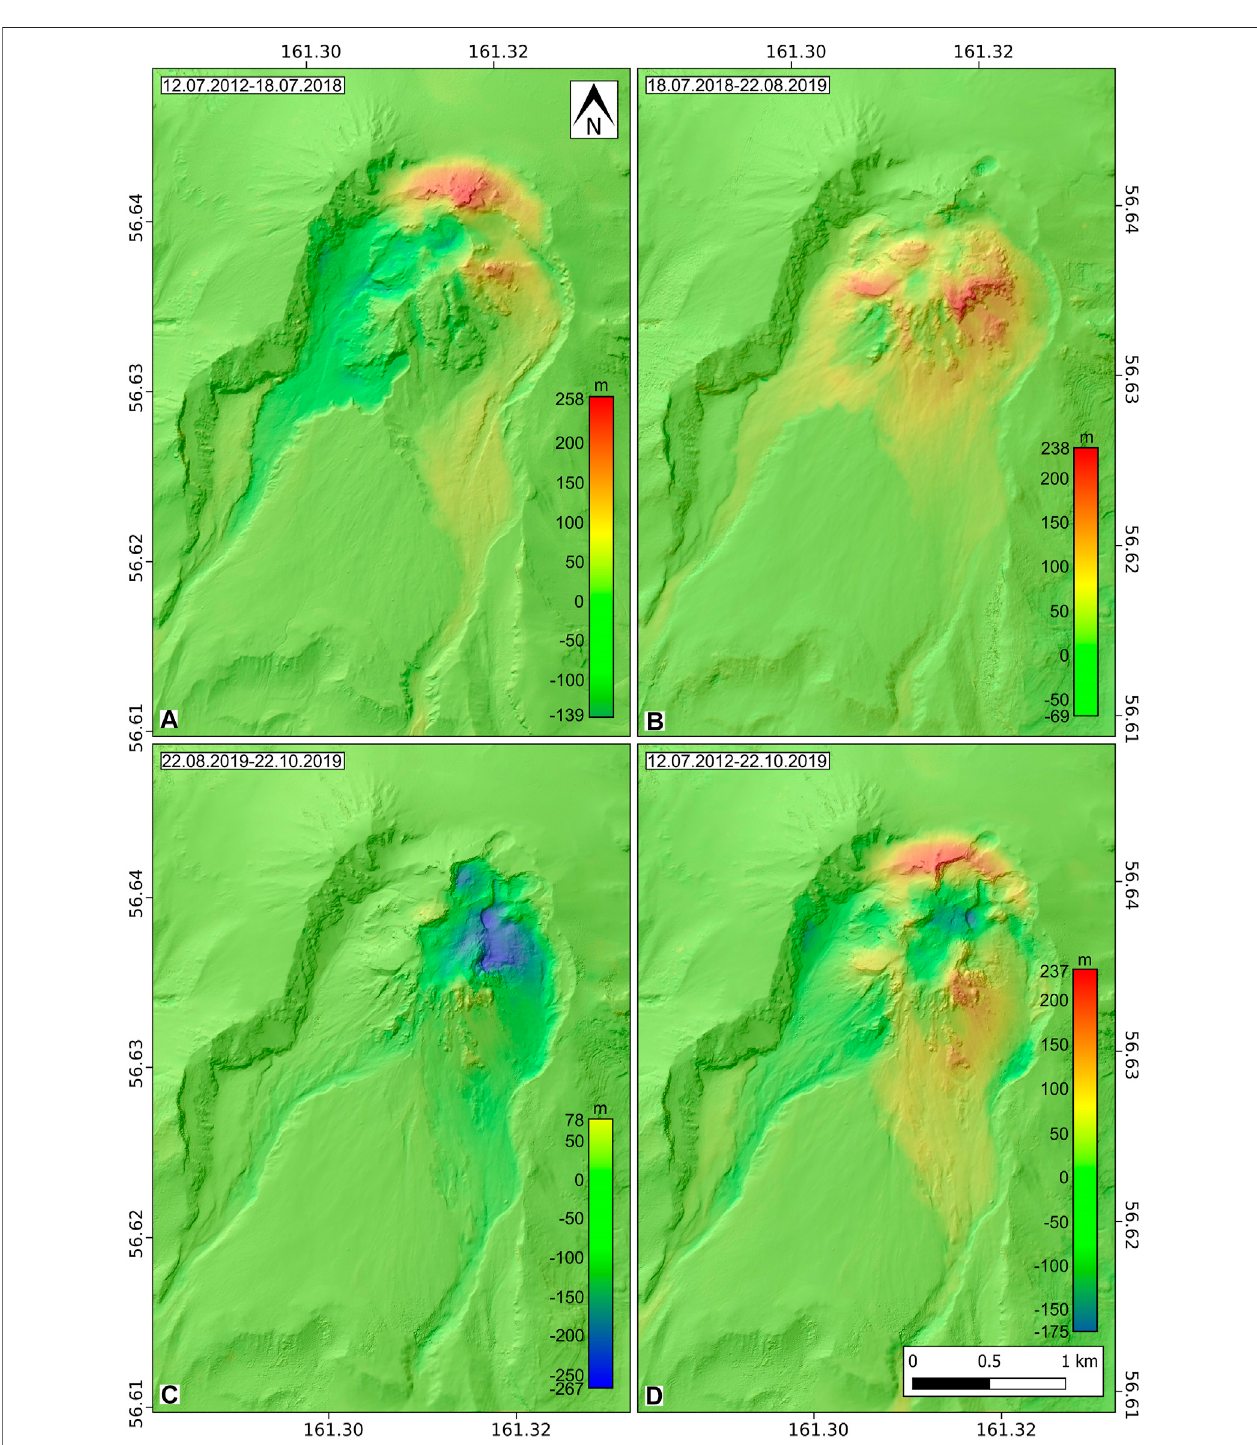
FIGURE4| IncrementalheightdifferencemapsgeneratedfromthebaseDEMandthe2018 – 2019DEMs.Greenindicatesnomajorchange,blueindicatesmaterial loss (destruction), and red indicates material addition (construction). (A) Comparison between the July 2012 and July 2018 DEMs; (B) comparison between the pre- December 2018 and post-August 2019 extrusive eruption DEMs; (C) comparison between the pre- and post-August 2019 explosive eruption DEMs; (D) comparison between the July 2012 and October 2019 DEMs (covering the whole period of study).